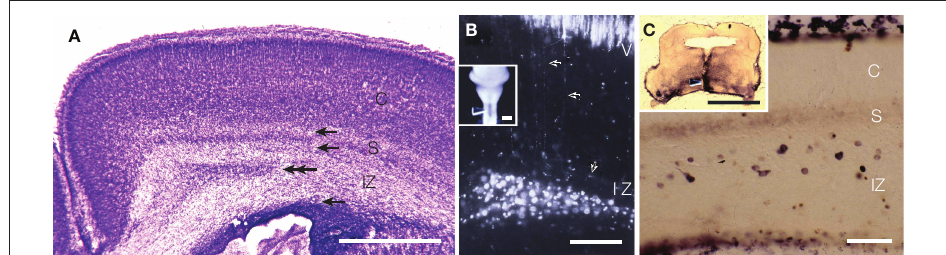
FiGure 4 | GABAergic subplate neurons in the intermediate zone (iZ) also extend their axon cortico-fugally. (A) Postnatal day 0 rat neocortex. Top and second arrows indicate the width of subplate according to Bayer and Altman (1991). Second and third arrows indicate the width of white matter which contains many GABAergic neurons. Double- arrows indicate the area where we found retrogradely labeled neurons after lipophilic red fluorescent dye, DiI injection into the median plane of the spinal cord. See insets in (B) . (B) DiI injection into the spinal cord (C1–C3) at P0 labeled pyramidal neurons in layer V and subplate neurons in the IZ. Axons of pyramidal neurons followed those of GABAergic subplate neurons rather than those of GABA-negative subplate neurons (layer VII). (C) Biotin-dextan-amine (BDA) injection into the primordium of pons at E18 rat labeled subplate neurons in the IZ at P0. CP, cortical plate; IZ, intermediate zone; S, subplate containing excitatory subplate neurons. Arrow heads in the insets in (B,C) indicate the injection site of DiI and BDA. Calibration bars in (A) , and in the insets in (B,C) are 1 mm. Calibration bar in (B) is 100 μm, that in (C) is 50 μm. (B) Adapted from Tamamaki et al.